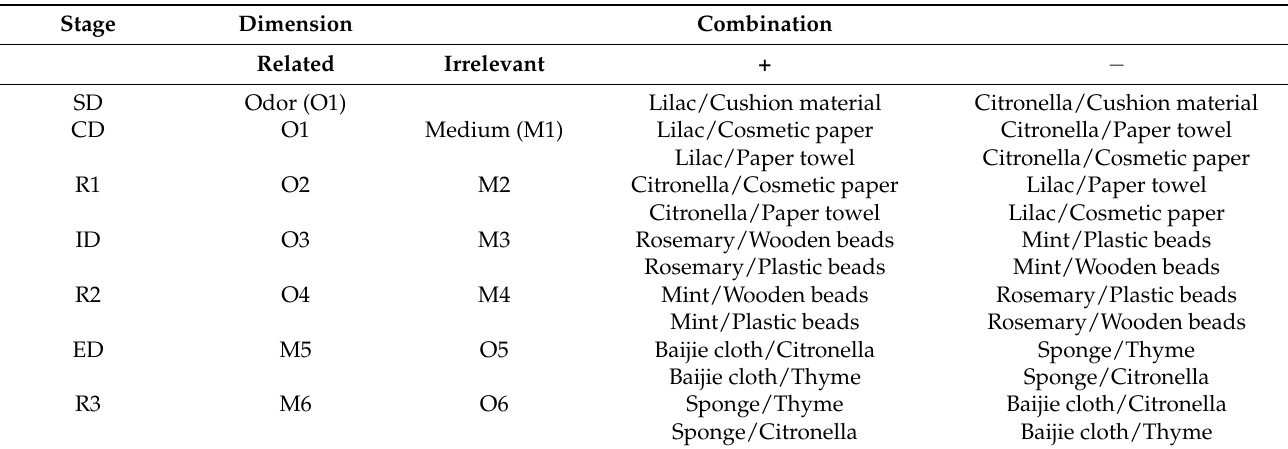
Table 1. The stages within the Attentional Set-Shifting